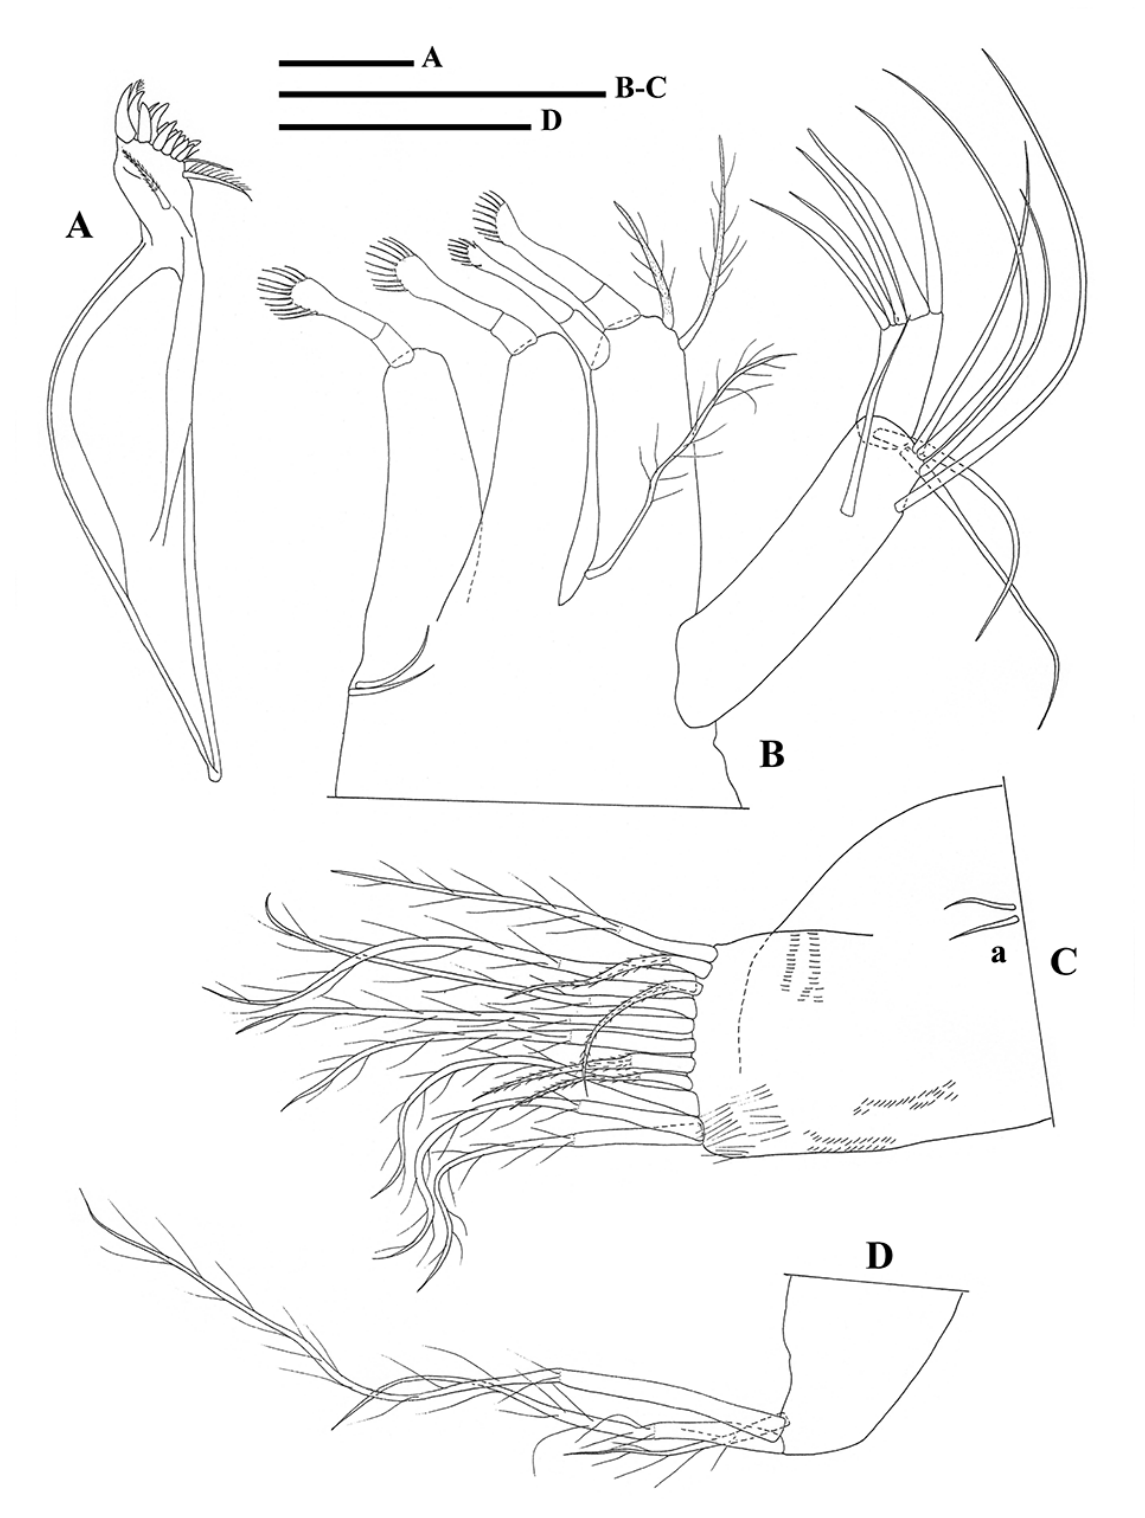
Fig. 3. Thaicypridopsis longispinosa sp. nov., ♀♀. A. Md-coxa (MSU-ZOC.257). B. Mx-1 (MSU- ZOC.264). C. T1 (idem). D. Endopodite of T1 (idem). Scale bars: 50